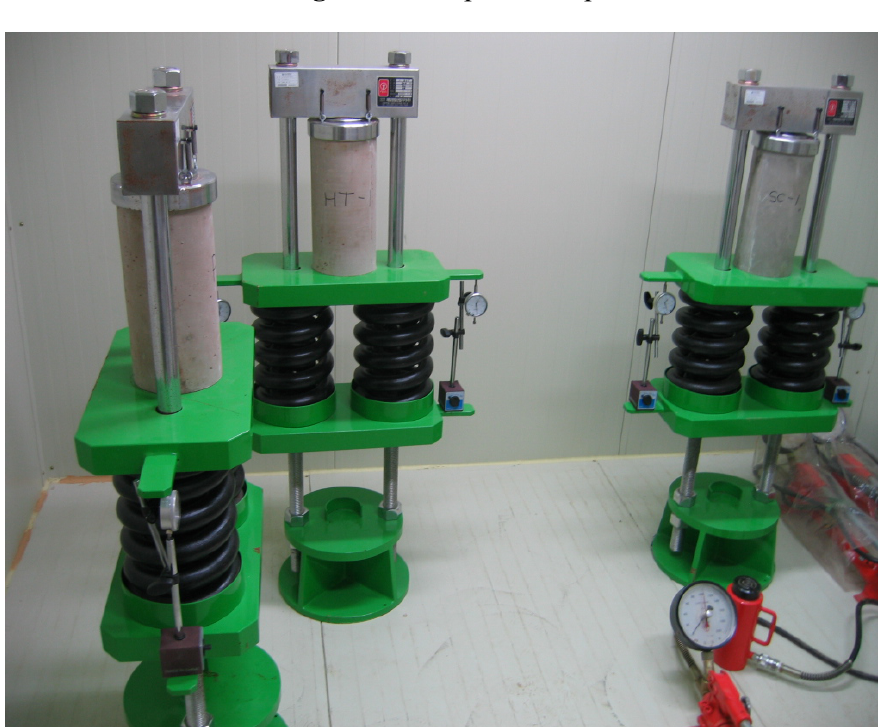
Figure 4. Creep test